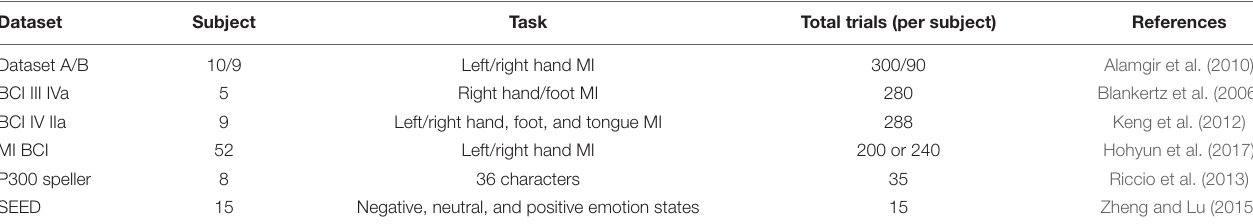
TABLE 1 | Publicly available EEG-based